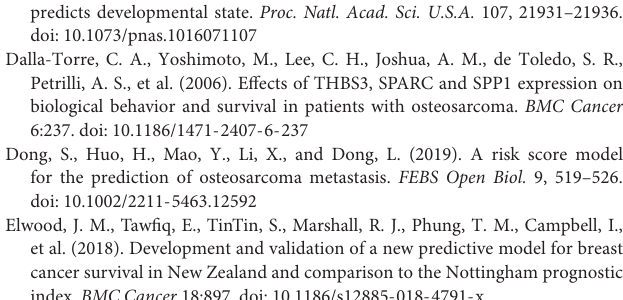
Supplementary Figure 1 | Multivariate Cox regression analysis and risk score model analysis of the validation dataset Target-OS ( N = 88). (A) Multivariate Cox regression analysis of dataset Target-OS based on the five-gene model. (B) Scatterplot displaying the risk score of each patient in the Target-OS dataset. The patients were divided into the high- or low-risk groups according to the risk score. The blue plots represent the patients in the low-risk group (risk score ≤ 0), while the red plots represent those in the high-risk group (risk score > 0). (C) Survival status distribution of the high- or low-risk groups in the Target-OS dataset. (D) The expression status of the five prognostic genes for patients in the Target-OS dataset. (E) K–M survival curves showing the difference in OS between high- and low-risk patients in the Target-OS dataset (log-rank test, p = 0.0438). (F) Time-dependent ROC curves analysis of survival prediction for patients in the Target-OS dataset using the five-gene prognostic model. The AUCs for 1-, 3-, and 5-year OS are shown in the figure. AUC, area under curve; K–M,